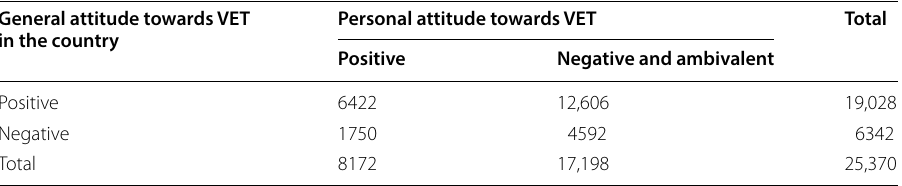
Table 1 General attitude towards VET in the country compared to the personal attitude towards VET (absolute